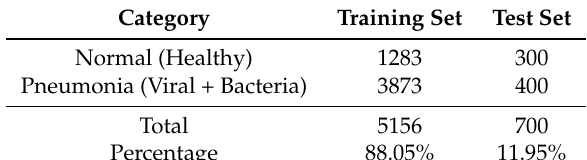
Table 1. Description of the experimental dataset.